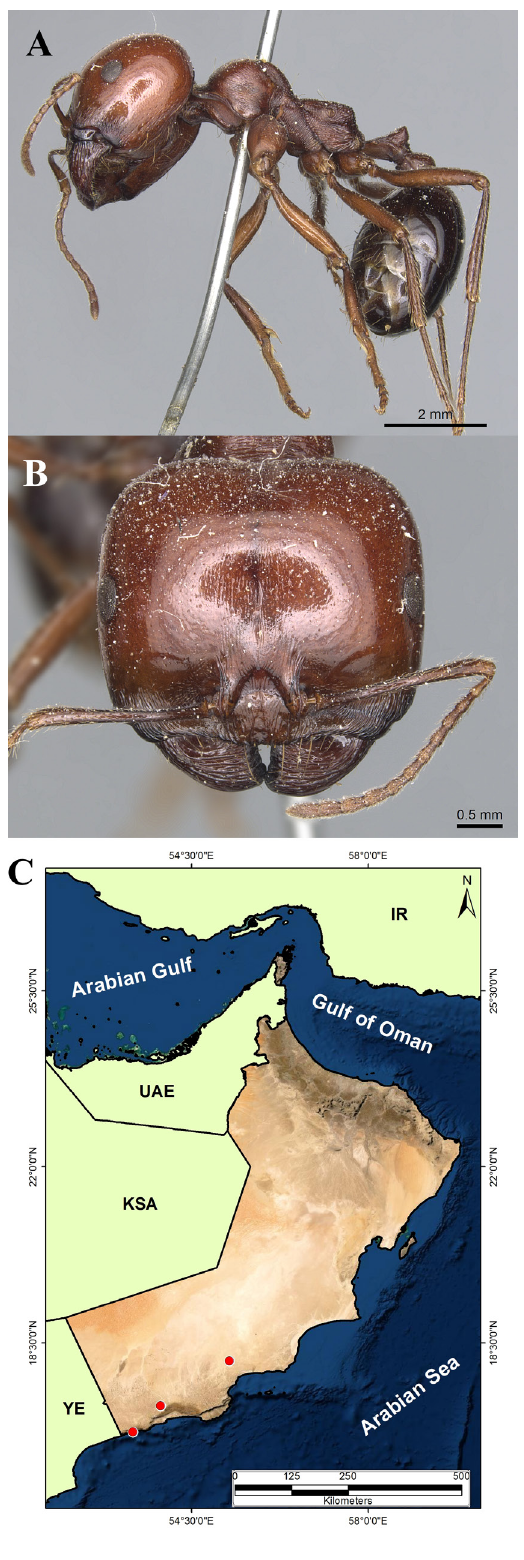
Fig. 35. Messor galla (Mayr, 1904), worker (CASENT0904127, AntWeb.org (Will Ericson)). A . Body in profile. B . Head in full-face view. C . Distribution